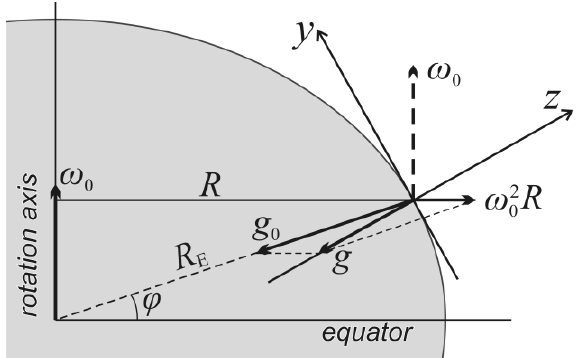
Figure 1. Illustration of the coordinate system.